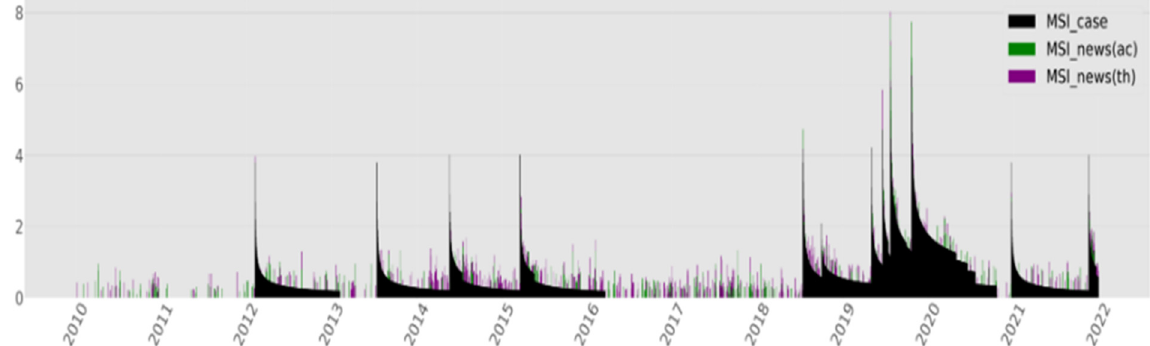
Figure 12. Military Security Index of Russia (‘10 ∼ ’21).